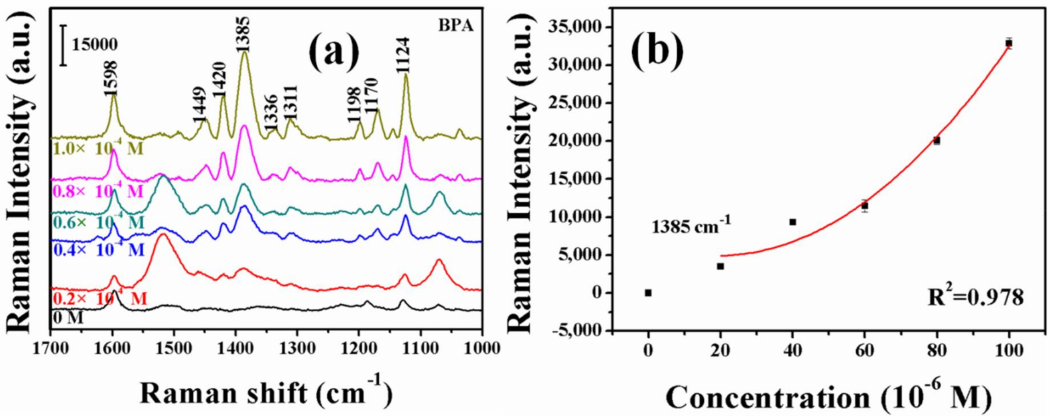
Figure 6. ( a ) Raman spectra after azo reaction of BPA at the concentrations of 1.0 × 10 − 4 M, 0.8 × 10 − 4 M, 0.6 × 10 − 4 M, 0.4 × 10 − 4 M, 0.2 × 10 − 4 M and 0 M, respectively; and ( b ) the plot of the SERS intensity of the band at 1385 cm − 1 for BPA as a function of the concentration.